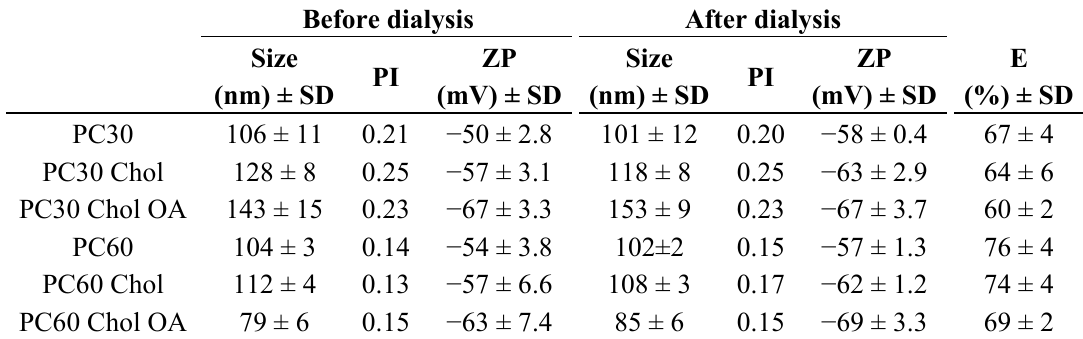
Table 2. Mean size, polydispersity index (PI), zeta potential (ZP) and entrapment efficiency (E%) of